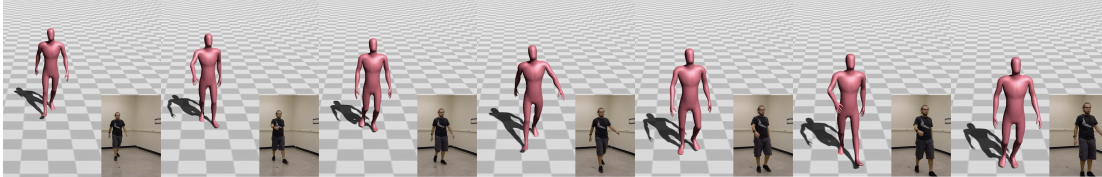
Figure 11. Example of walking motion reconstructed with the proposed method when the IMU placed on user’s right